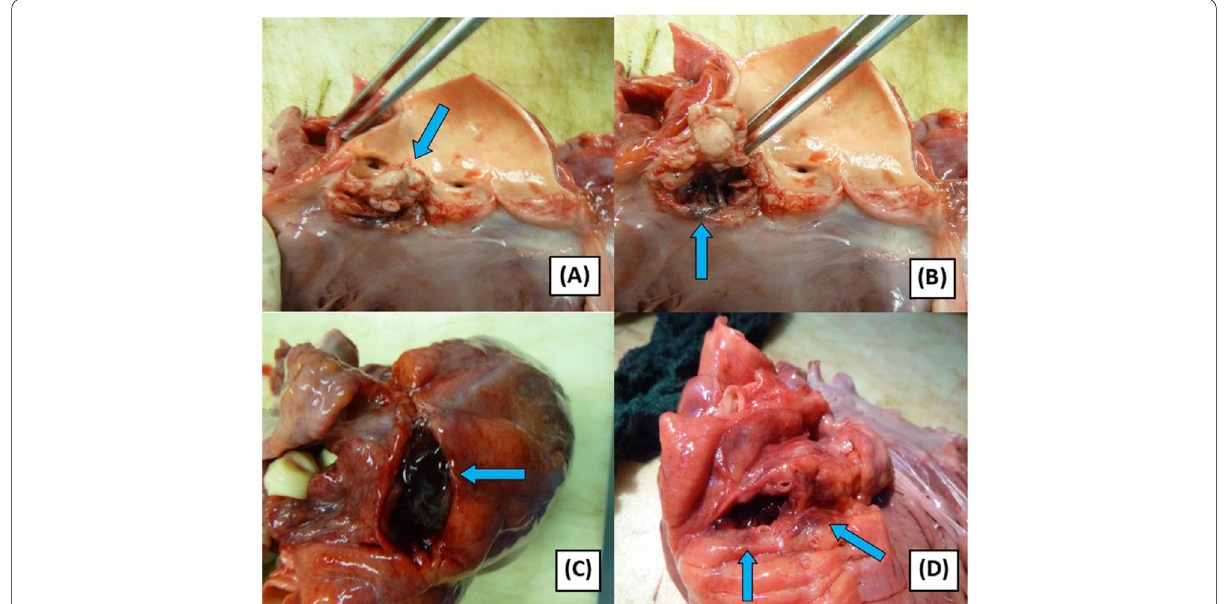
Fig. 1 A Cut section of the left ventricle of the heart shows a large, mobile vegetations affecting the left coronary cusp of the aortic valve (arrow). The right coronary cusp is slightly affected. B There is a hollow area within the myocardium beneath the vegetations, with an ulcerated opening (arrow). C Cut section of the bulging epicardial surface of the left ventricle revealed large amount of blood clots within the myocardium (arrow). D The pseudoaneurysm contains blood clots and impinges on the coronary artery. The surrounding myocardium is hemorrhagic and soft in consistency, in keeping with acute myocardial infarction